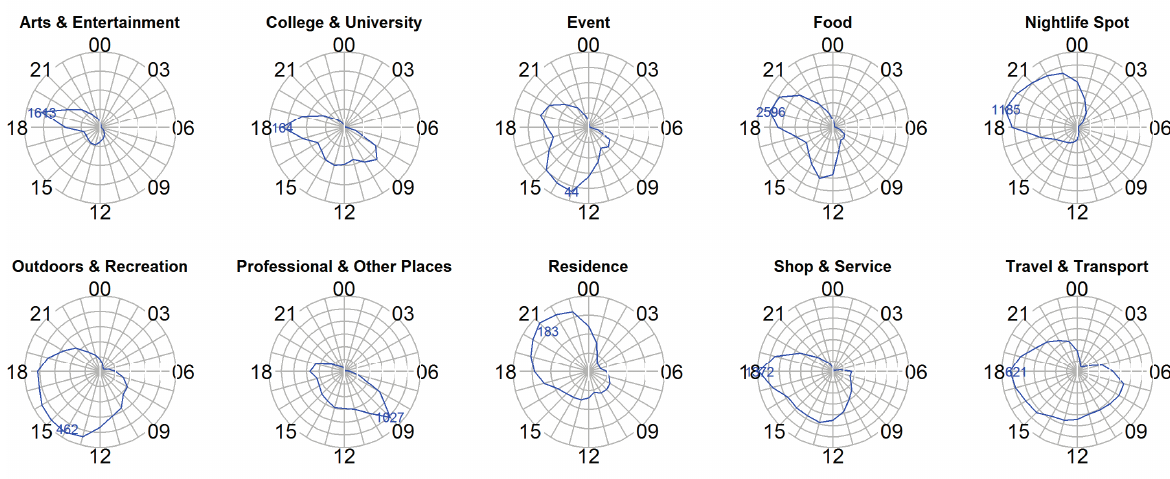
Figure 2. Users’ check-in behaviors per hour and over a 24-h period for each category.